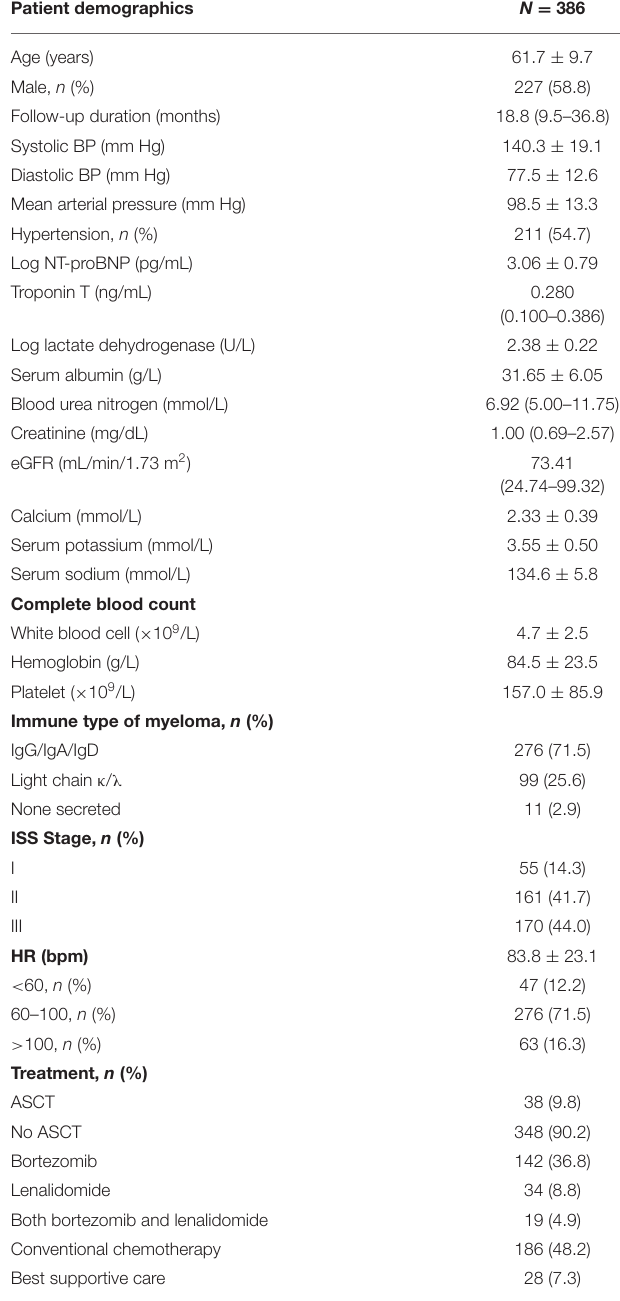
TABLE 1 | Baseline characteristics of all